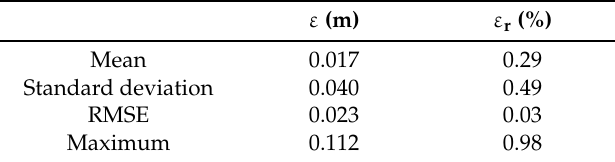
Table 3. Quality evaluation of the 3D point cloud obtained with the IMAS: General statistics.